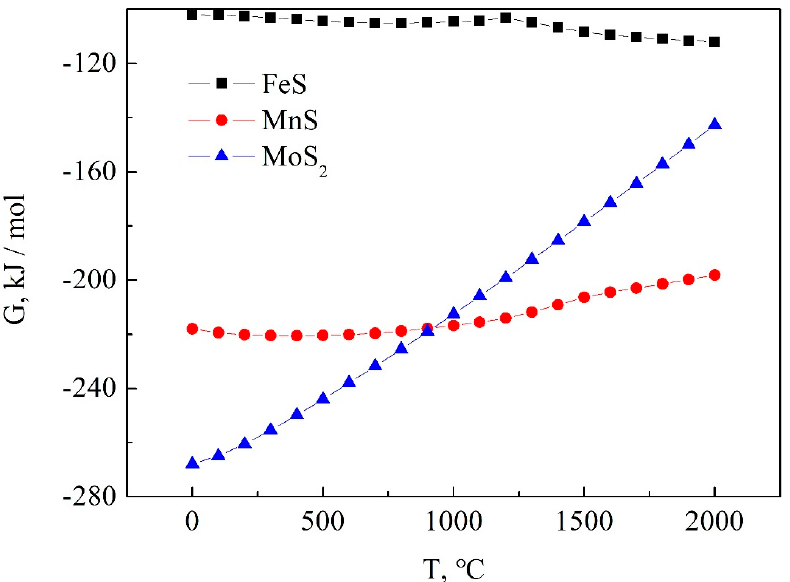
are obtained from HSC